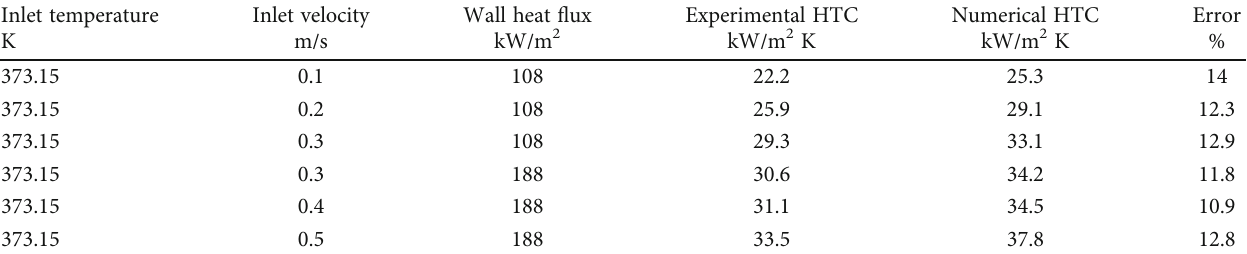
Table 1: Comparison between the simulation results and experimental